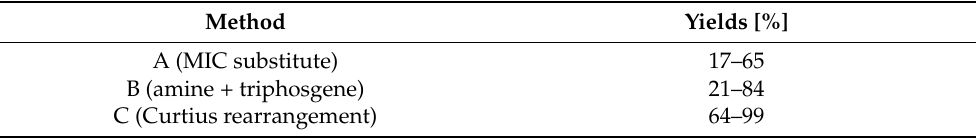
Table 1. Comparison of yields of different synthetic